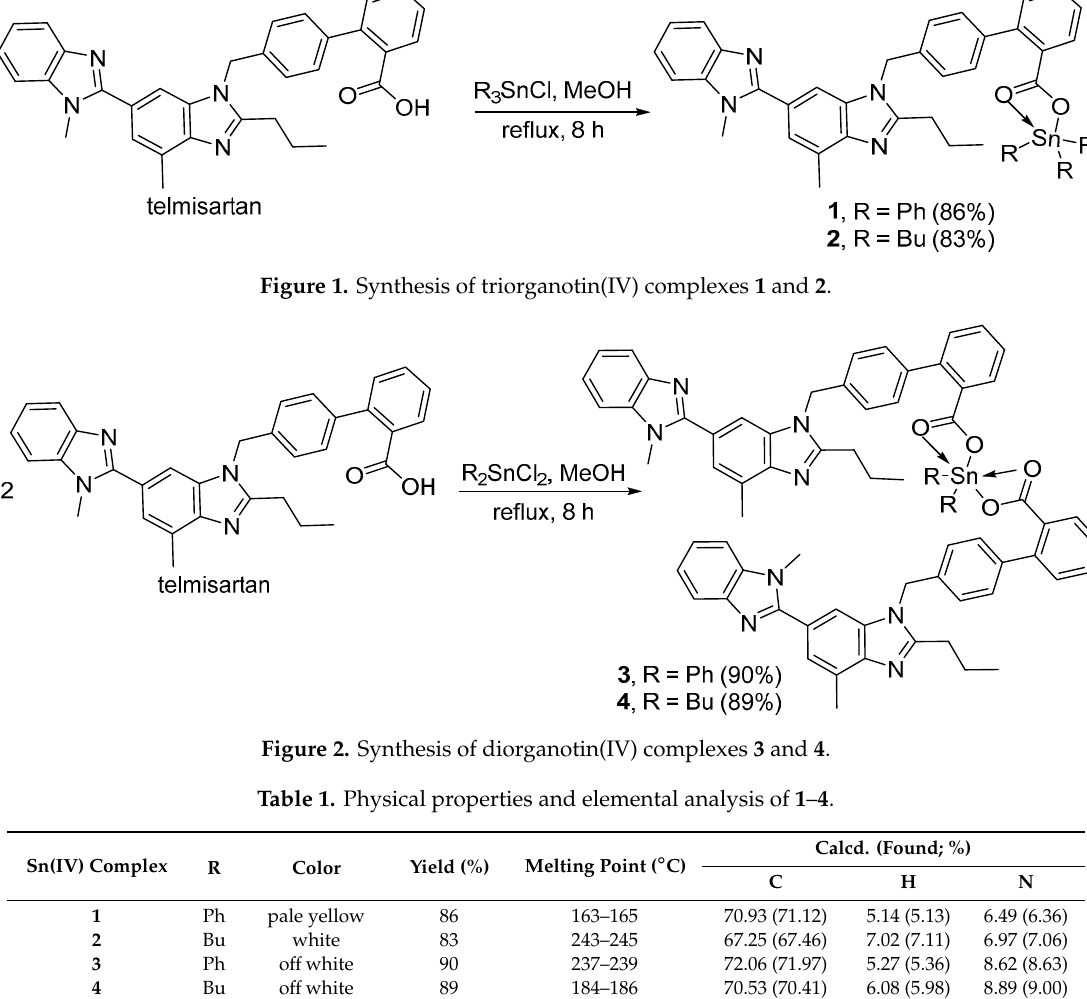
Table 2. Key FTIR spectral data of complexes 1–4